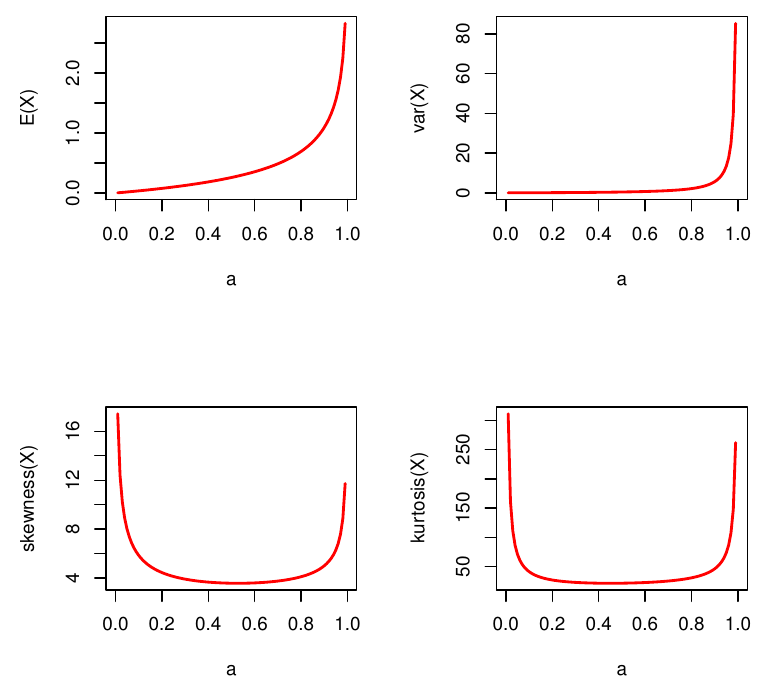
Figure 2. Descriptive statistics of DWPLT